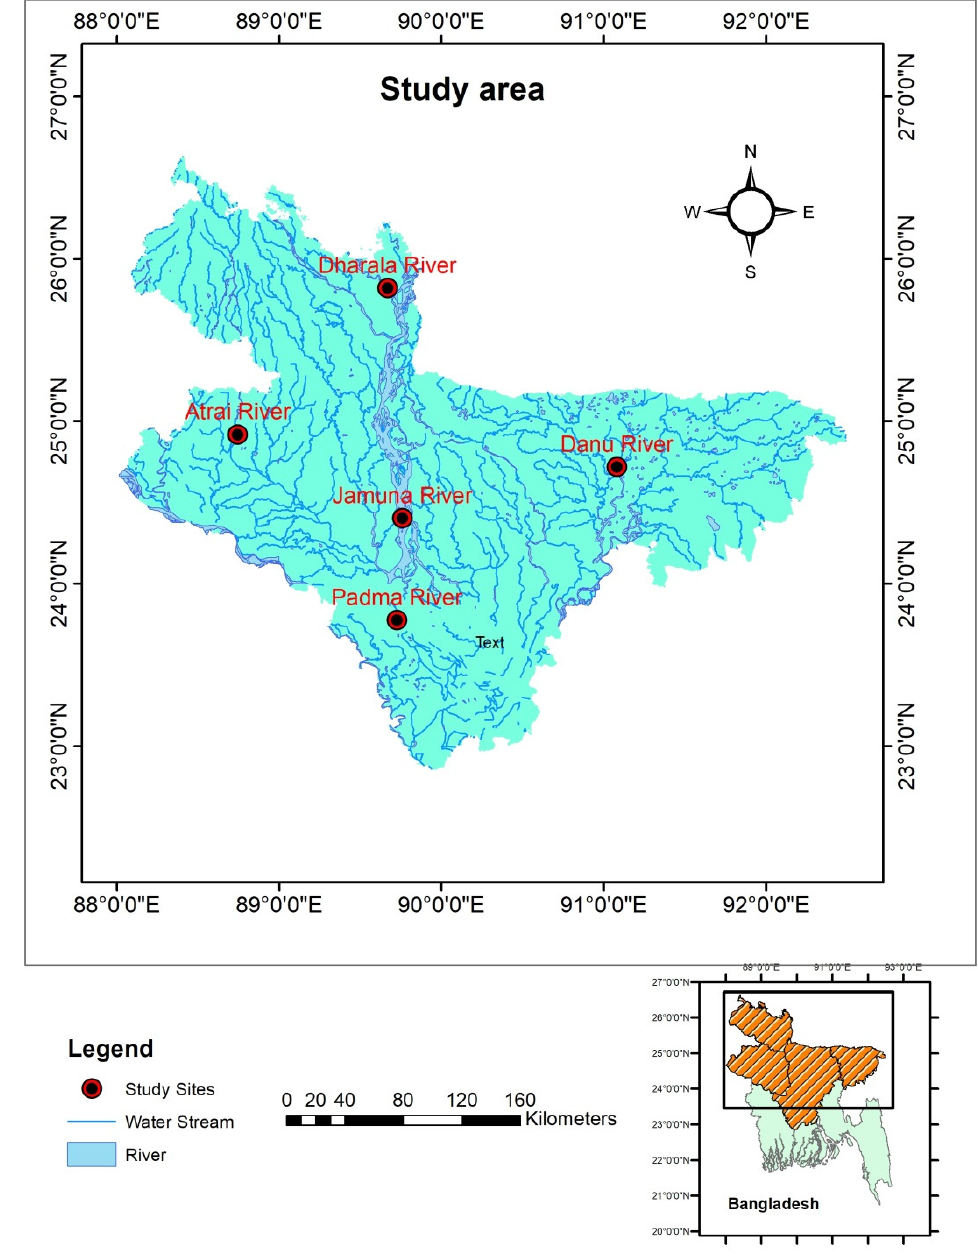
Figure 1. Map showing the collection sites of Botia dario from five rivers of Bangladesh.